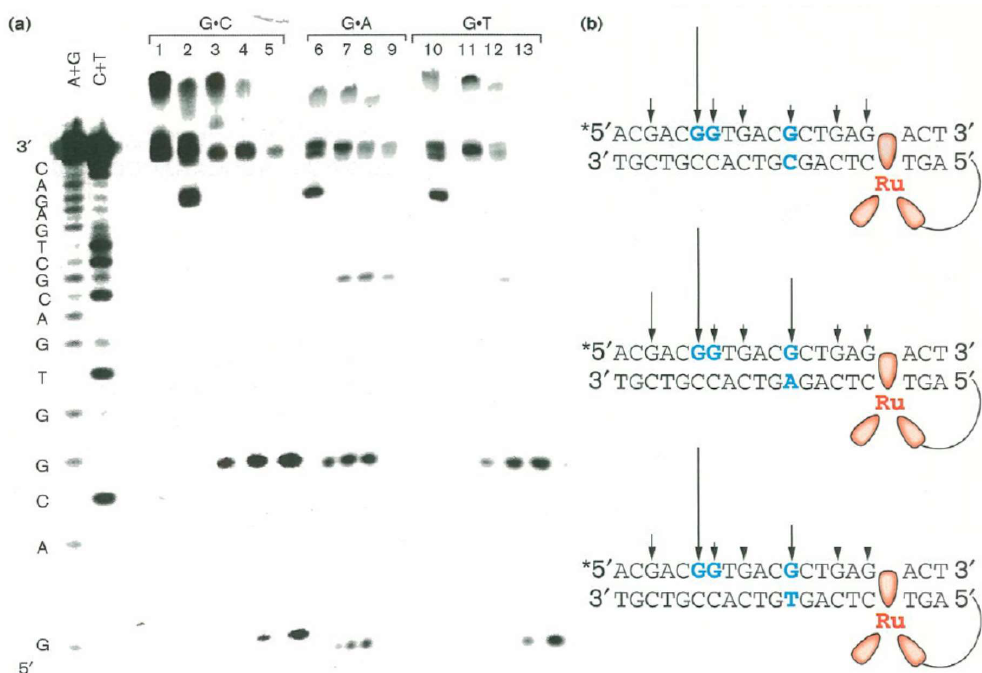
Figure 3. ( a ) PAGE analysis comparing the long-range oxidative damage on Ru(II)-modified DNA in duplexes with a G·A or G·T mismatch with damage in a complementary duplex. ( b ) Sequences of the duplexes used in the analysis. Arrows indicate the position of DNA damage as well as intensity of cleavage. Blue letters indicate the position of the mismatches as well as the GG doublet. Figure taken from [83] with permission.